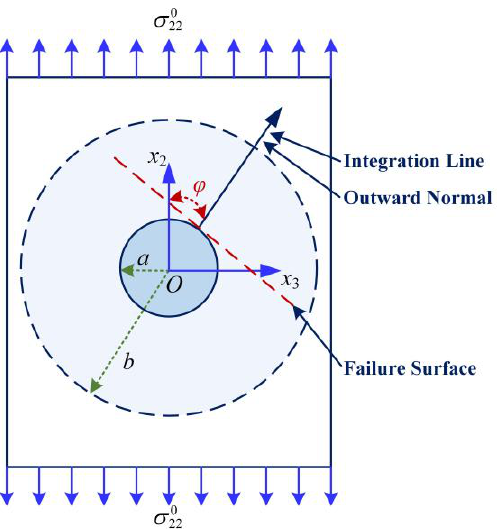
Figure 2. Schematic of the averaged stress used in defining stress concentration factor of the matrix in a composite subjected to a transverse load.